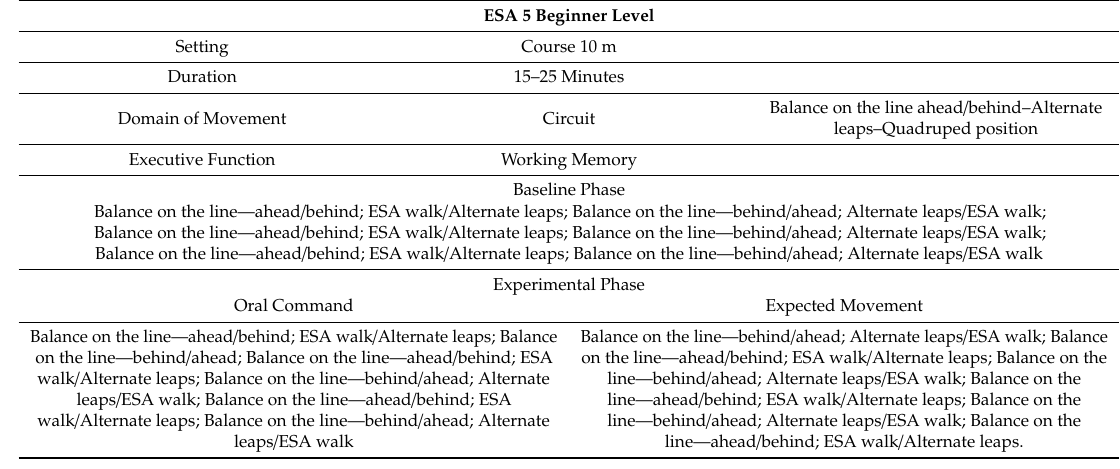
Table 2. Enriched Sports Activities-Program (ESA-Program) Unit 5 for beginners